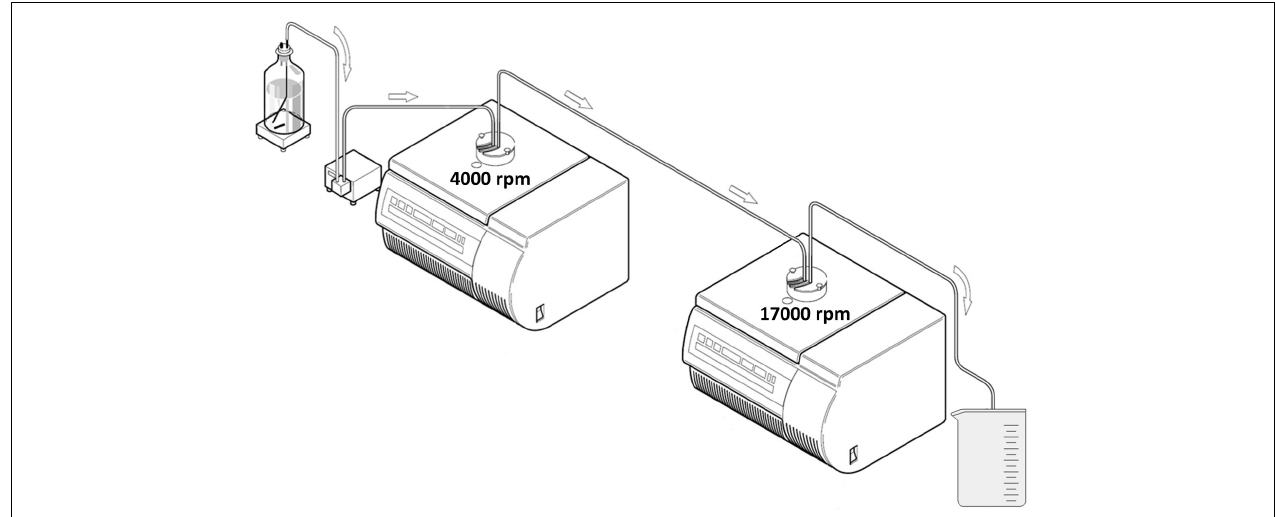
FIGURE 2 | Schematic drawing of the experimental setup for sequential CFC. In our experimental design, the first centrifuge was operated at 4000 rpm and the second one at 17000 rpm (modified, © Thermo Scientific).